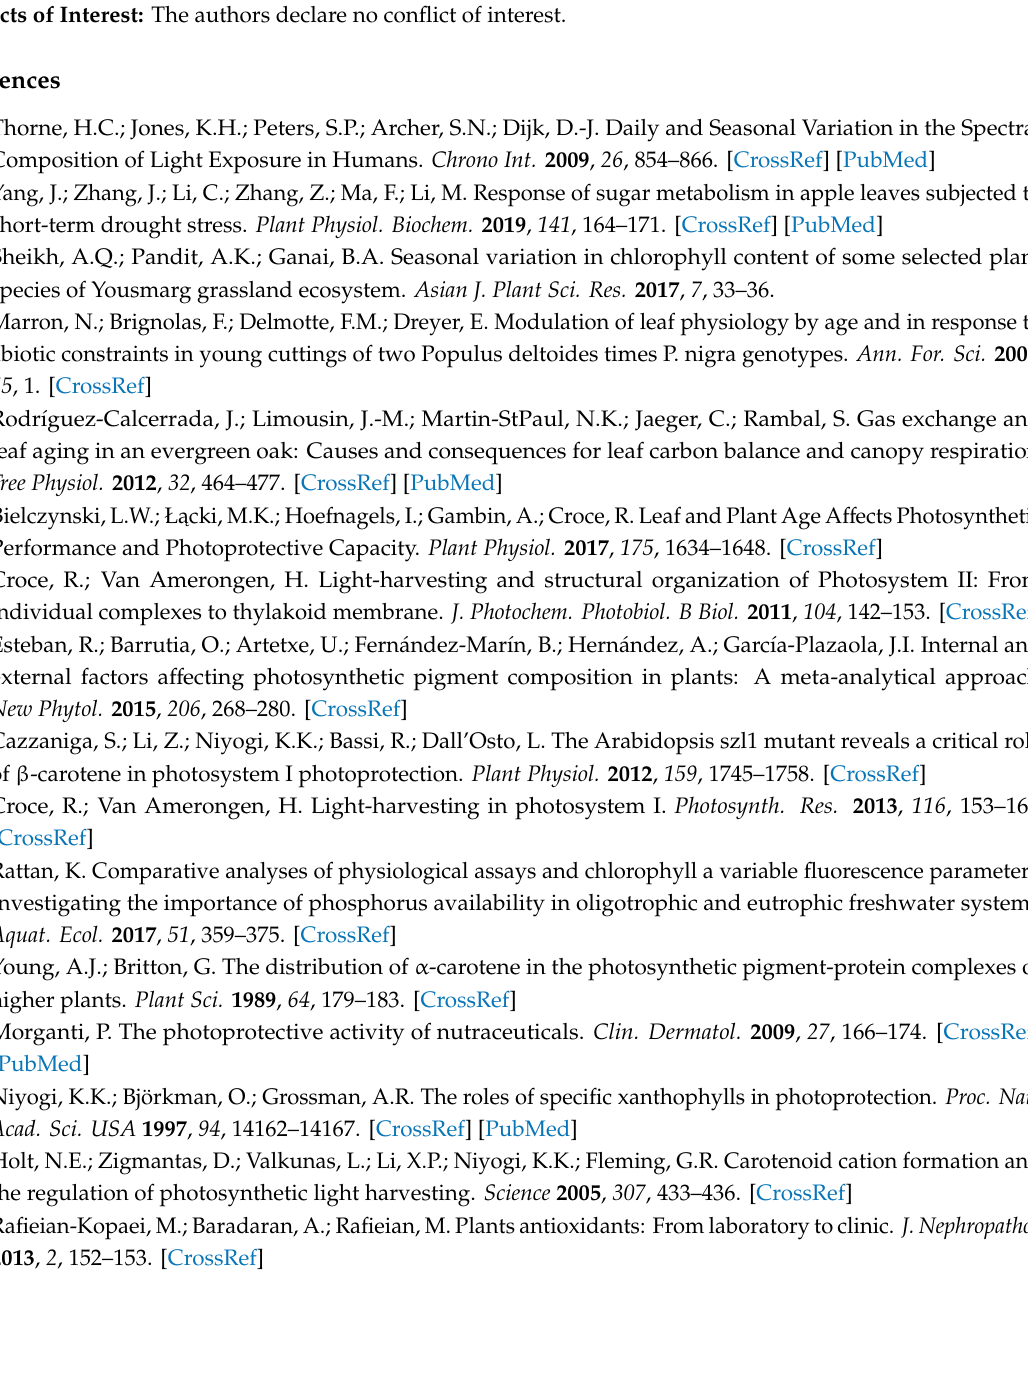
Table S1: E ff ect of distances between trees and seasonality on the photosynthetic indices, Table S2: E ff ect of distances between trees and seasonality on the photosynthetic pigments, Table S3: E ff ect of distances between trees and seasonality on the